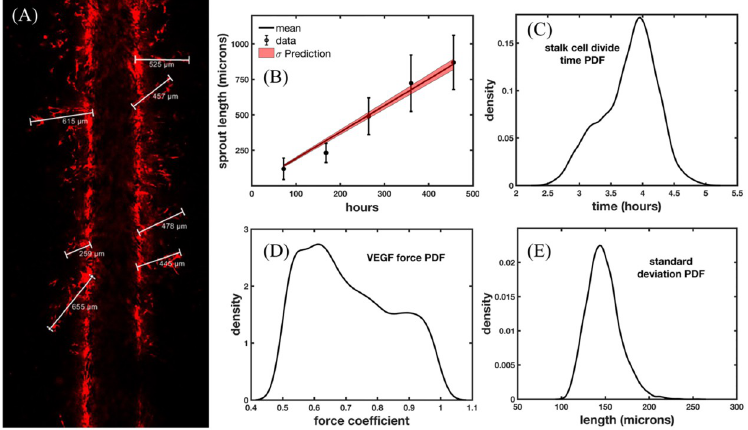
Fig 4. Calibration and prediction scenario for stalk cell divide time and sprout length measurements. Fig 4A displays the Day 11 length measurements from the confocal microscopy images of the angiogenic vasculature in the 3D microfluidic platform outlined in the experimental methods of Scenario 3 (Section 2.2.2). These specific vessels were selected since they were observable at Day 3 and tracked throughout the remaining time points. The length measurements over time are depicted in Fig 4B, where the dots show the mean of the measurements, and the error bars show the standard deviation. The red region depicts the standard deviation of the prediction of the calibrated mathematical model with calibrated posterior distributions of each parameter shown in Fig 4C and 4D and 4E. Fig 4C depicts the posterior distribution of the stalk cell divide time, Fig 4D depicts the posterior distribution of the VEGF Force, and Fig 4E depicts the posterior distribution of the standard deviation which has been calibrated as a hyperparameter in this scenario. The average error of predicted sprout length over time is 15.3%. The calibrated stalk cell divide time posterior distribution is utilized in the subsequent global